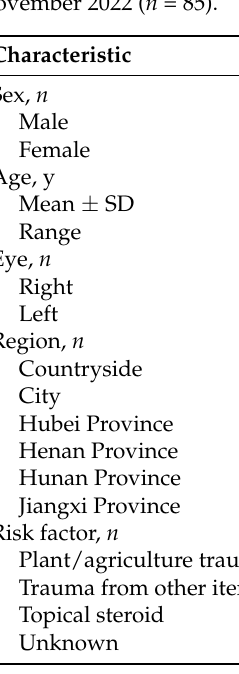
Table 1. Characteristics of patients with FK admitted to Wuhan Union Hospital from October 2021 to November 2022 ( n =